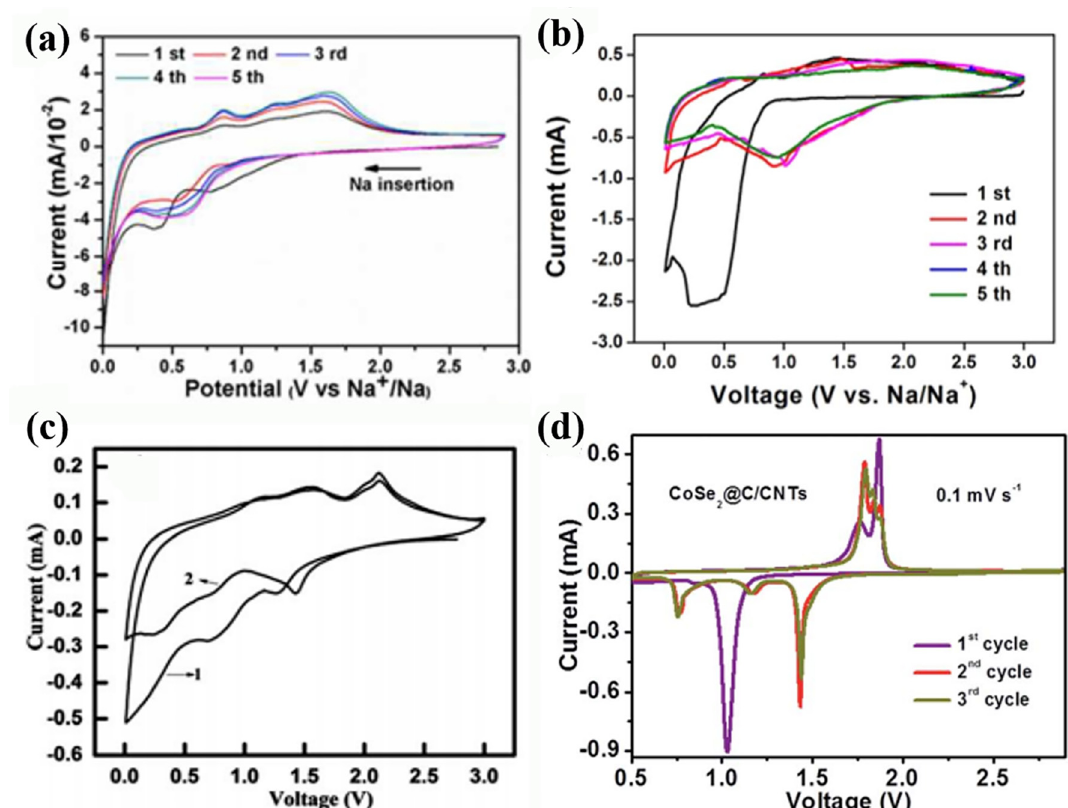
Table 1. Li + storage mechanism of some Co x A y -active materials.